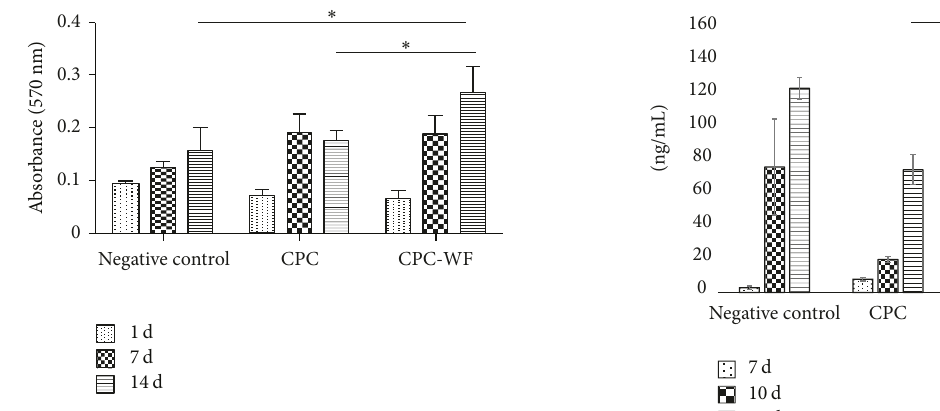
Figure 1: MTT assays after 1, 7, and 14 days of cell culture on CPC disks. Data are expressed as means and standard deviation. 𝑝 values of < 0.01 are indicated by an asterisk.